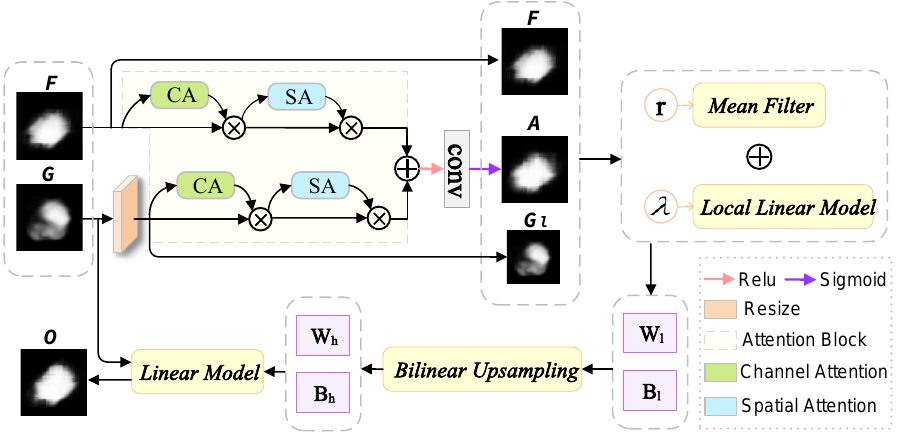
Figure 3. CSFAG model